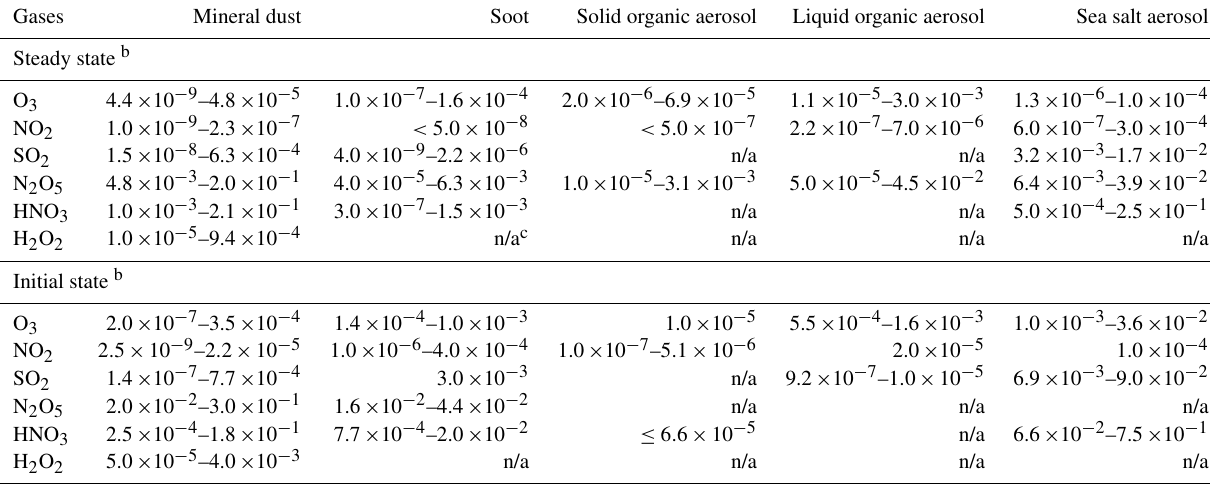
Table 1. Aerosol uptake coefficients ( γ eff ) observed in laboratory experiments a . Gases Mineral dust